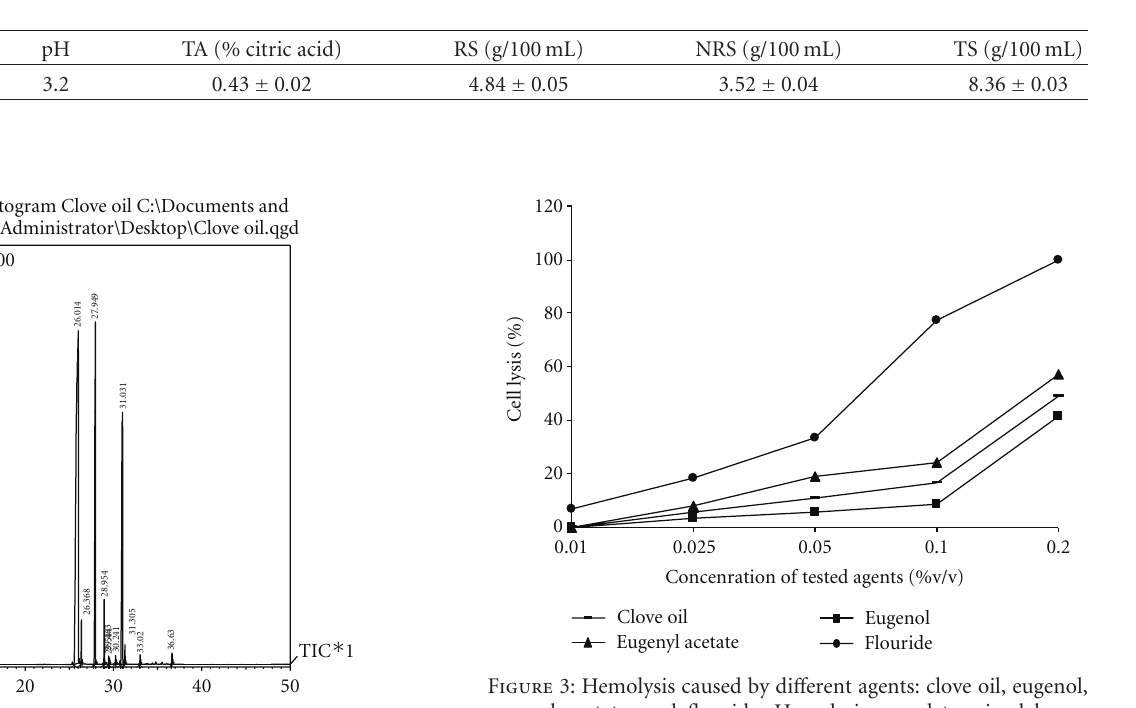
Table 2: Mean values of apple juice for endogenous pH, titratable acidity (TA), reducing sugars (RS), nonreducing sugars (NRS), and total sugars (TS).